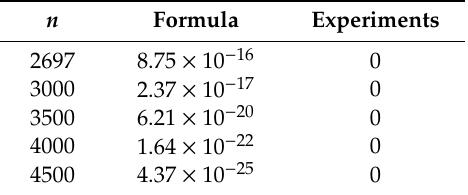
Table 6. Probability that the OOV algorithm will incorrectly estimate one-bit of the noise vector whose weight is correctly estimated as 78.